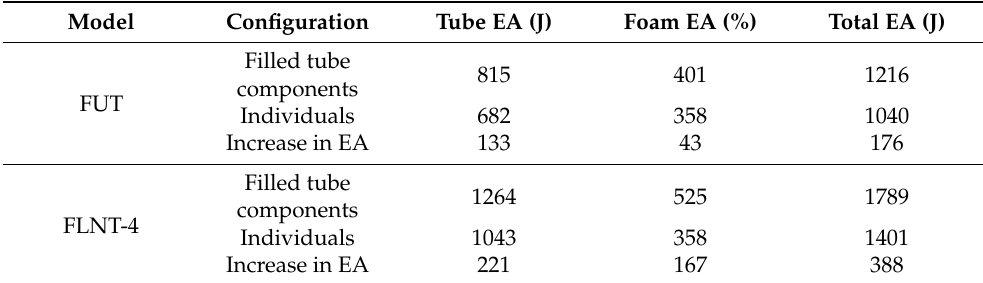
Table 11. Partition energy absorption and contribution of interaction effect via FE analysis.